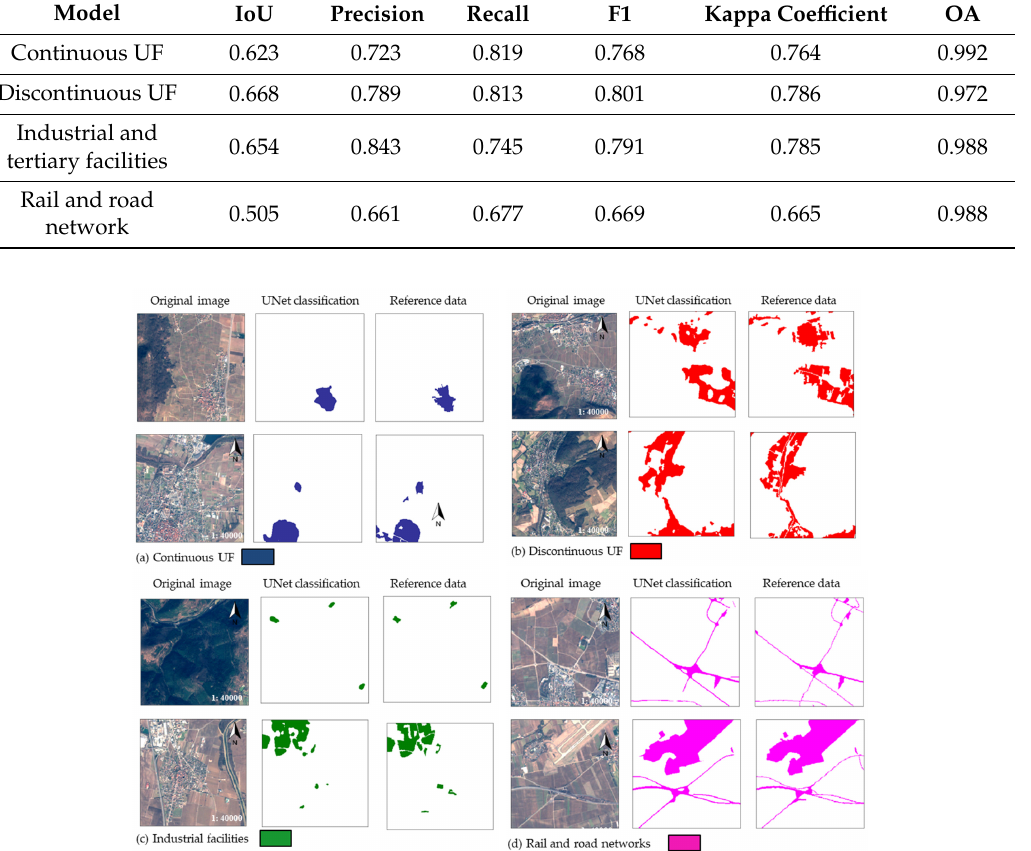
Figure 13. Classification results on the validation set per class